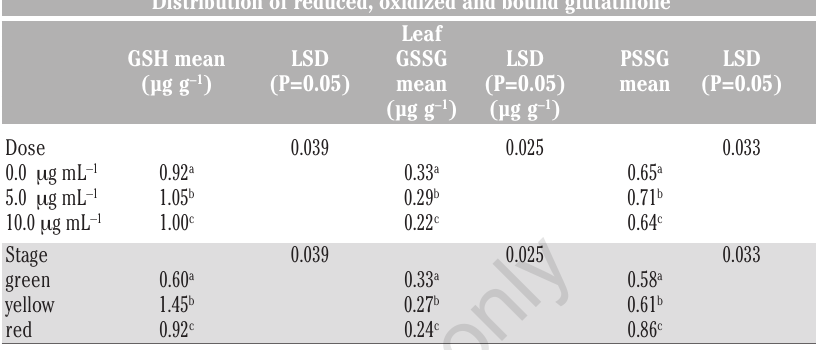
Table 2. Means and least significant differences (LSD) (P = 0.05) of the concentration dis- tribution GSH, GSSG and PSSG in tomato fruit at three different stages of maturation following application of SA at 5.0 and 10 (cid:0)g mL –1 .